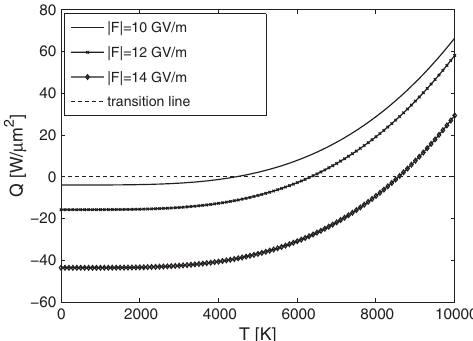
FIG. 5. Q , the Nottingham heat flux leaving the surface as a function of temperature for three values of electric field, j F j . Negative values indicate heat entering the system. T (cid:4) , the temperature at which the heat flux is zero, is higher than the melting temperature of copper for the electric fields, considered. Specifically T (cid:4) ¼ 4500 K , 6300 K, and 8600 K for j F j ¼ 10 GV = m , 12 GV = m , and 14 GV = m ,